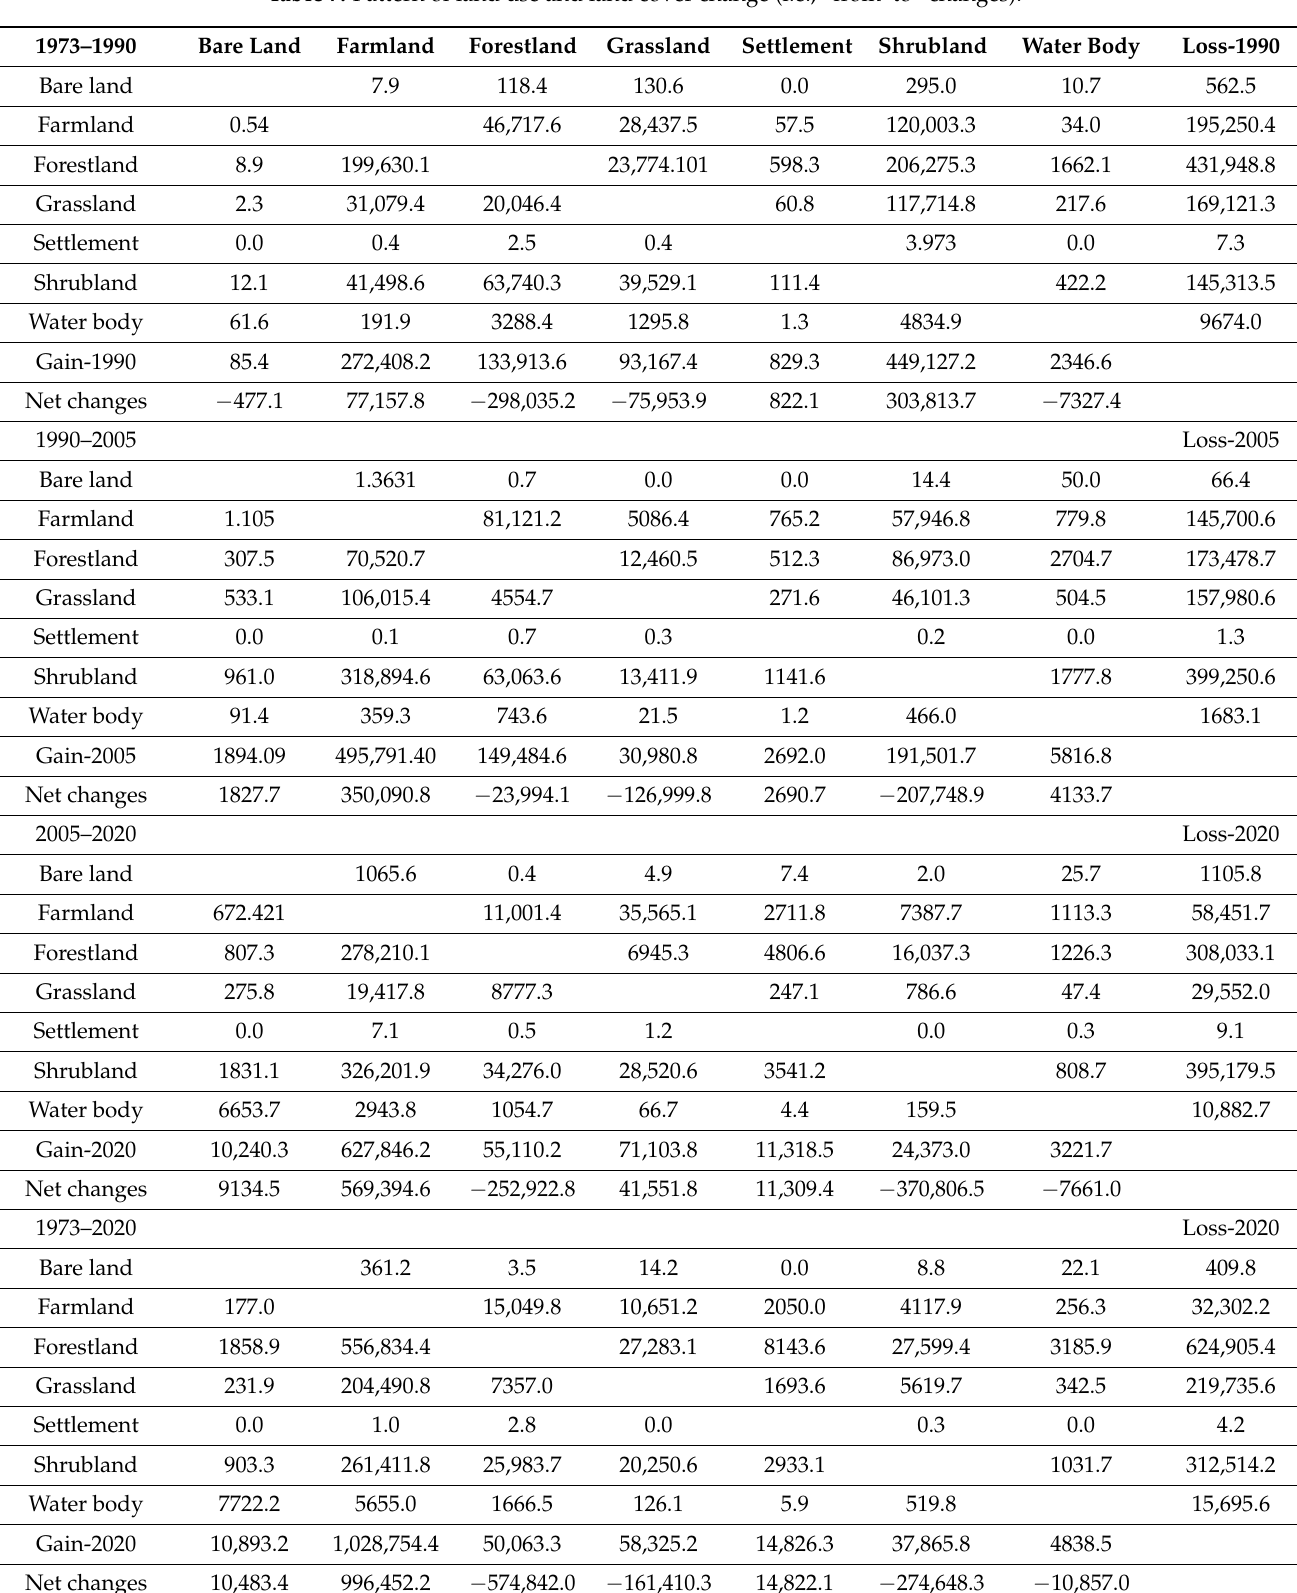
Table 7. Pattern of land use and land cover change (i.e., “from–to”